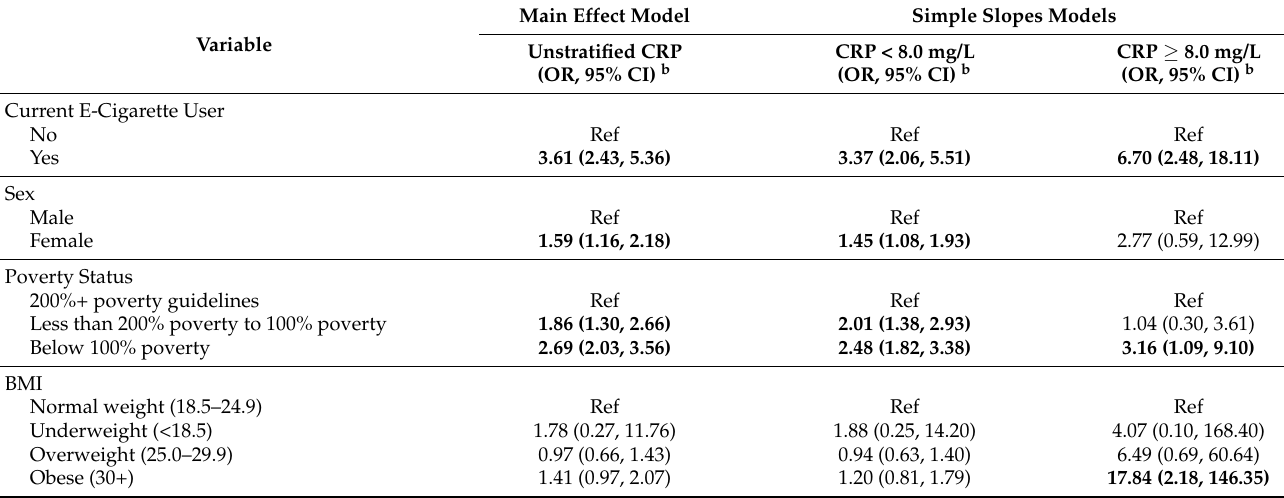
Table 3. Odds of Depression in Multivariable Analysis Among All Current E-cigarette Users a Stratified by Level of